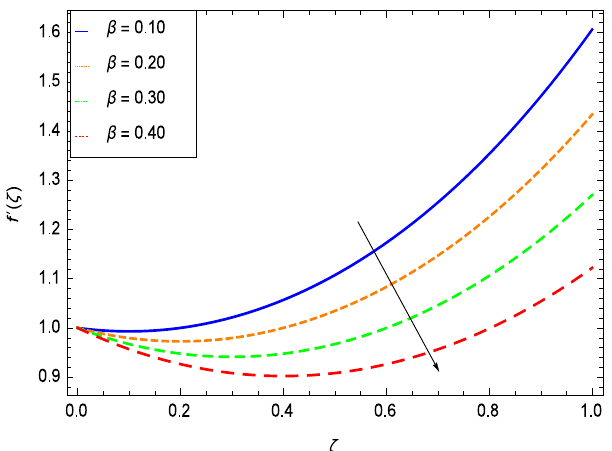
Figure 4. Flow layer at h = − 3.00, φ = 0.40, n = 1.50, We = 0.50, S = 0.50, M = 2.00, A = π enhancement in β .